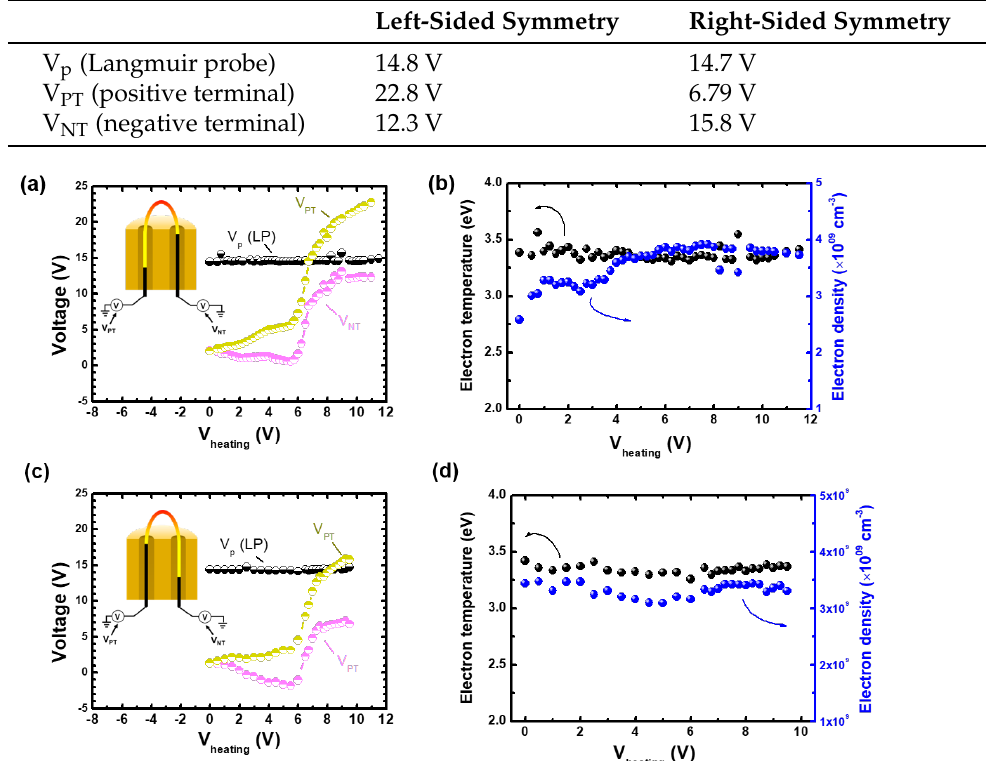
Table 1. Summary of measurement results of Langmuir probe (LP), and positive and negative terminals of emissive probe.